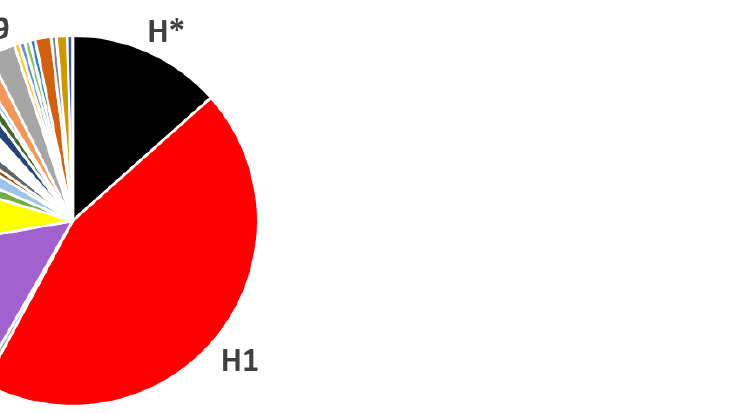
Figure 2. Overview of haplogroups behind the most common West Eurasian CR haplotype revealed by complete mitogenome sequencing ( n = 216). The proportions of the 22 first-level subhaplogroups of haplogroup H are shown, combining any subclades, and only those with five or more representatives are named, viz. H1 (44.0%), H3 (13.9%), H7 (7.4%), H13 (2.3%), H26 (2.3%), H59 (2.3%), and H* (13.9%). Colors correspond to the colors used in Figure 3. The paragroup H* is included as a single unit (see text and Table 2 for details).